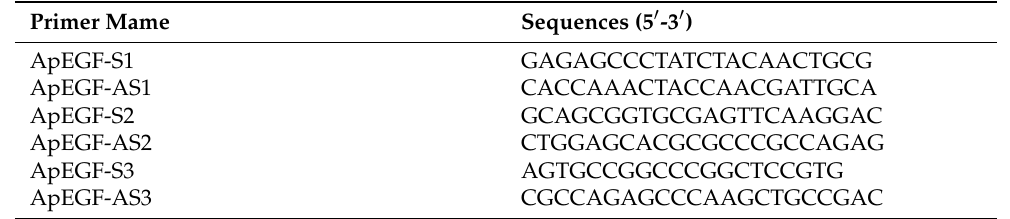
Table 2. List of primers for inverse